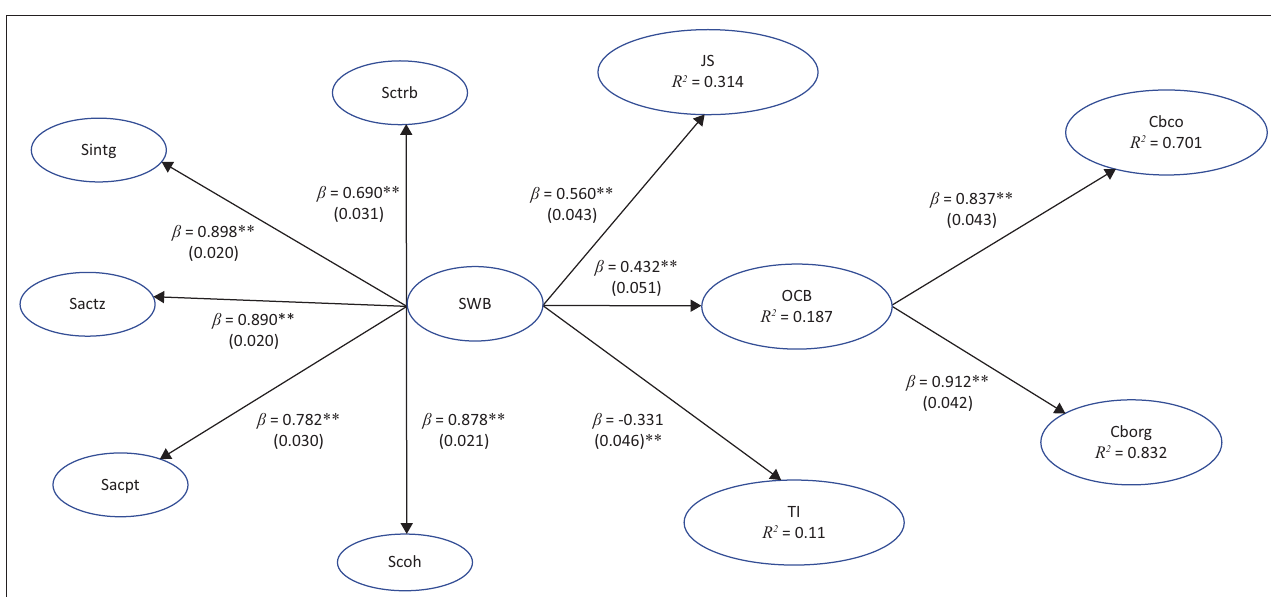
FIG URE 1: Standardised path coefficients for the best-fitting model (standard errors are in